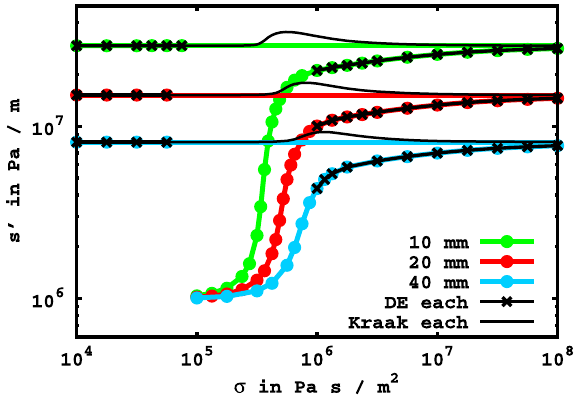
Figure 11. Dynamic stiffness per unit area s 0 for different values of the thickness d according to the legend: the exact value, the calculation according to [2] using the standard procedure, the calculation according to the German preamble of [3] (DE), and calculation according to Kraak